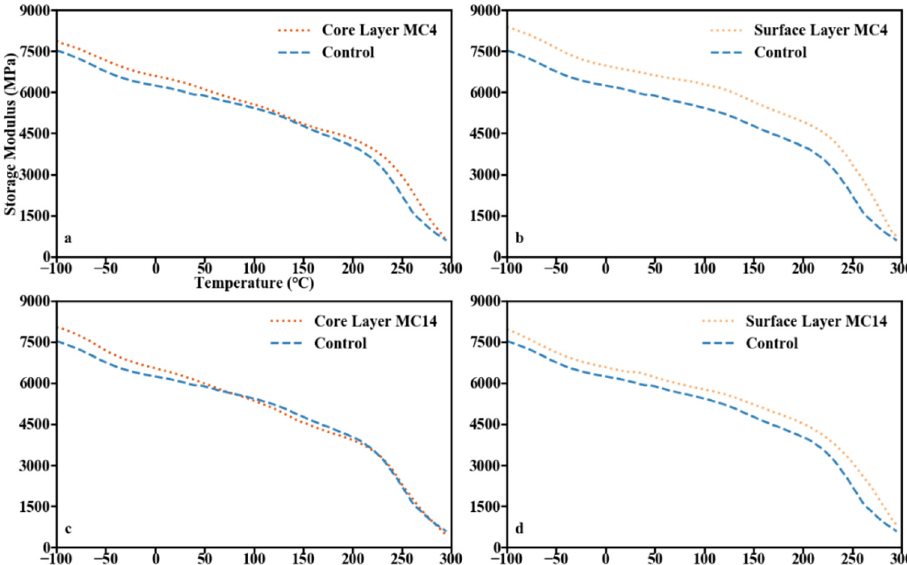
Figure 7. Comparison of sample storage modulus over temperature between the control sample and: ( a ) core layer of sample MC4; ( b ) surface layer of sample MC4; ( c ) core layer of sample MC14; ( d ) surface layer of sample MC14.